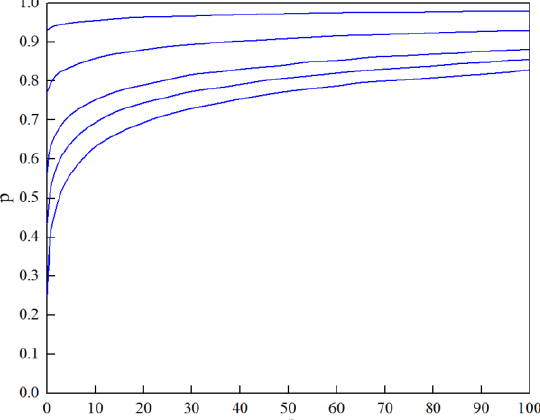
Figure 12. Pore pressure distribution surrounding the wellbore for high-speed flow of gases in porous media.